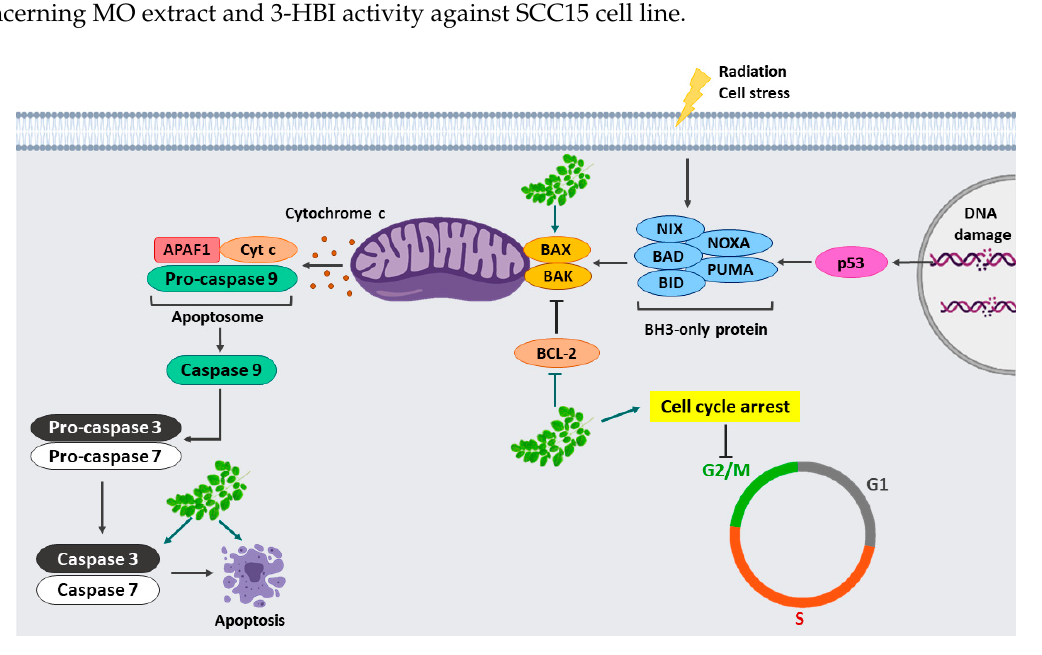
Figure 8. Apoptosis signalling pathway and cell cycle arrest in response to Moringa extract and 3-HBI. MO crude extract and 3-HBI induced G2/M cell cycle arrest and apoptosis in SCC15 cell line by increasing the Bax and cleaved caspase-3 expression and downregulating the levels of Bcl-2.